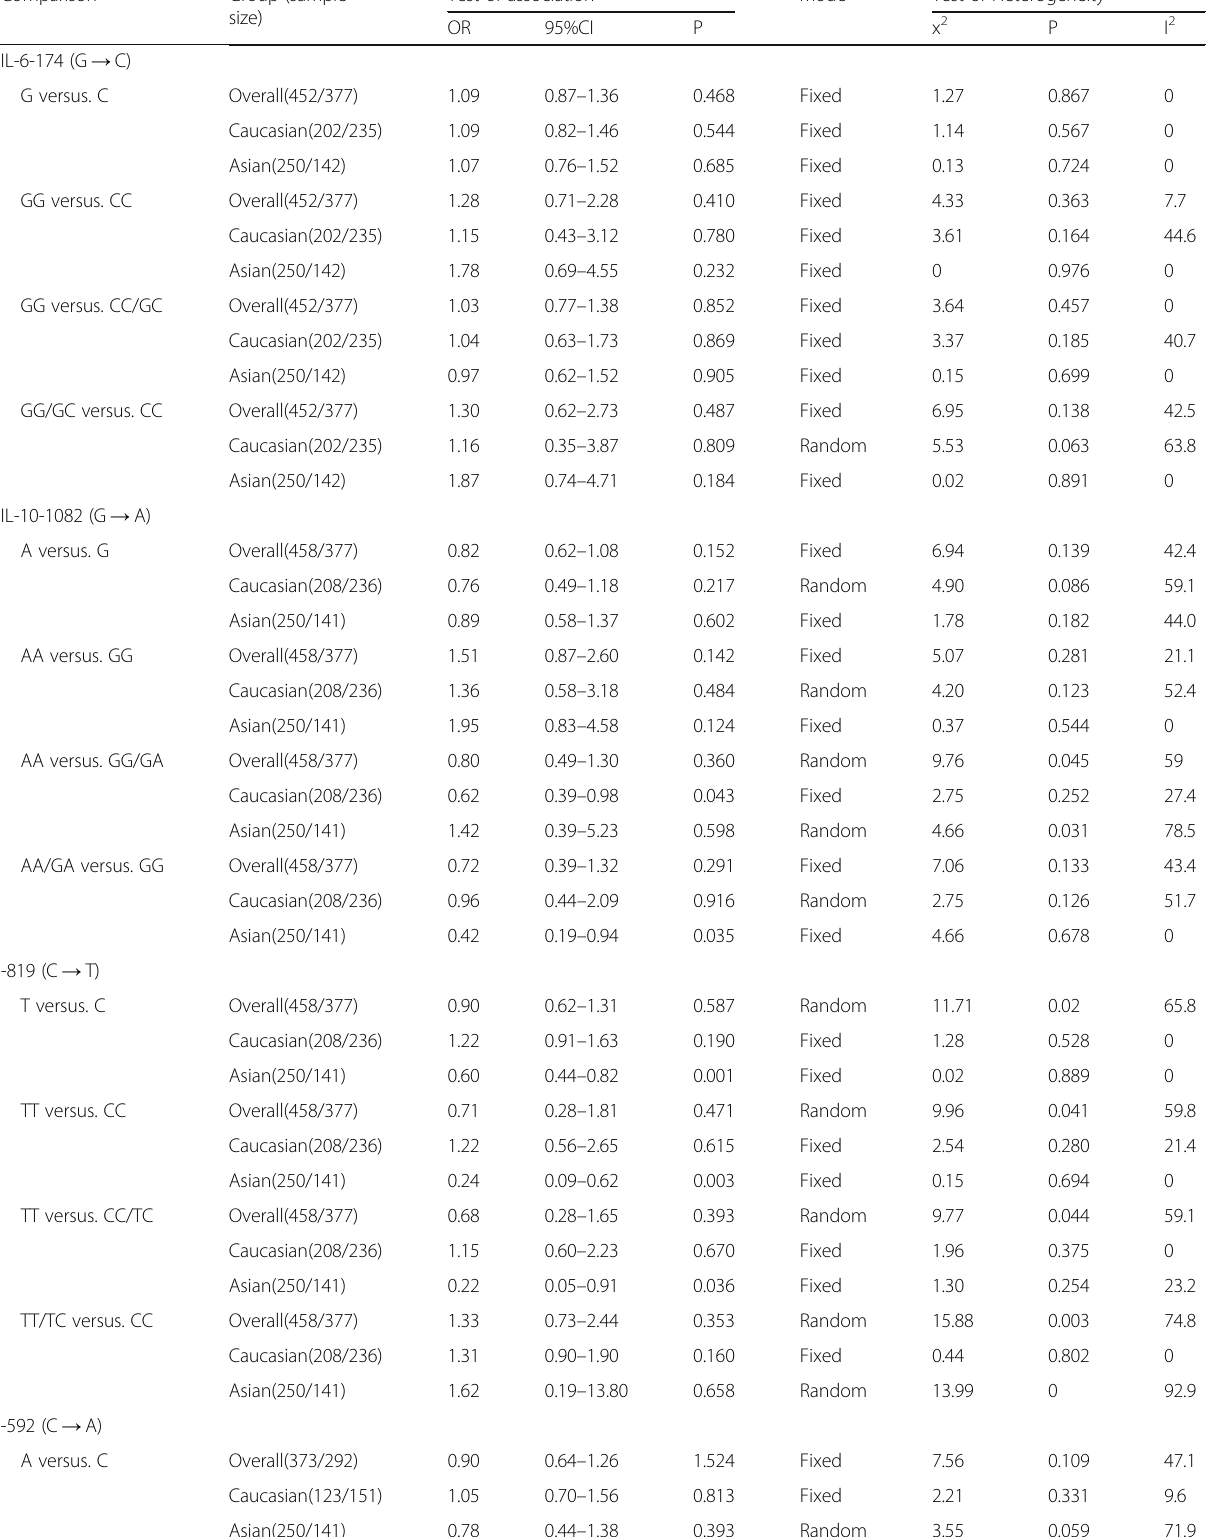
Table 3 The general results for the association between IL-10, IL-6 polymorphisms with Brucellosis risk Comparison IL-6-174 (G → C)